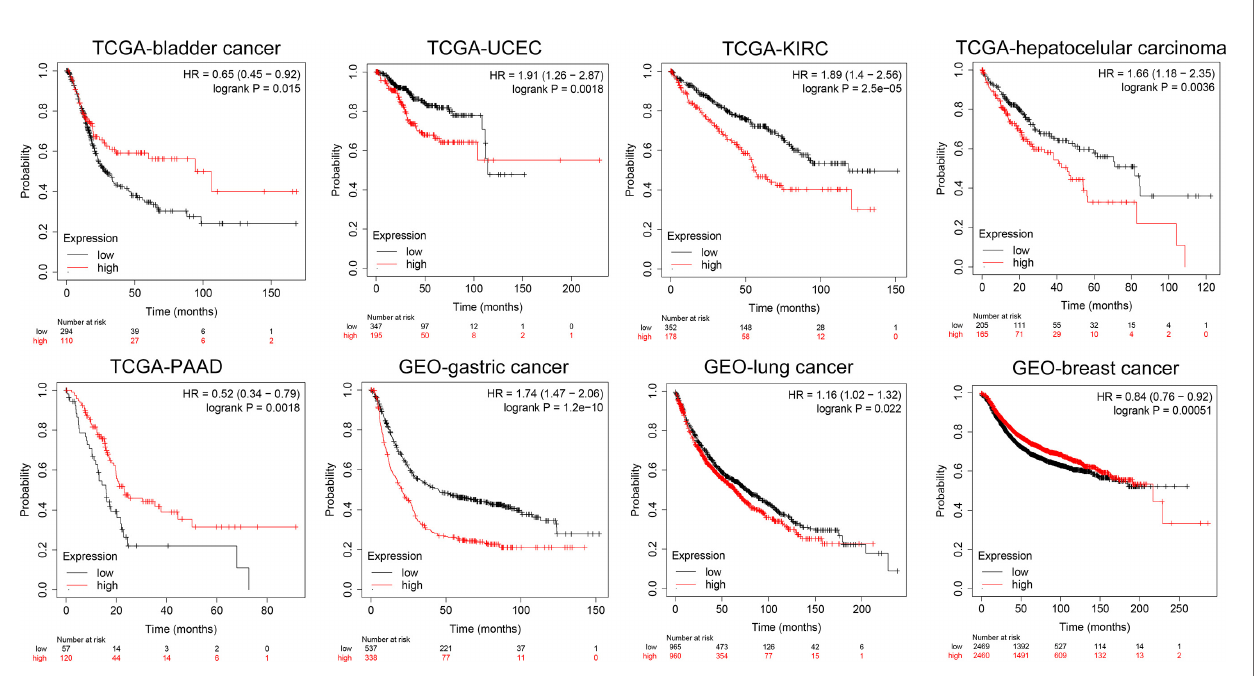
FIGURE 4 | Subgroup survival analysis indicated high expression of KCC2 is associated with poor survival for pan-cancer patients. Bladder cancer (HR = 0.65, p = 0.015, TCGA), PAAD (HR = 0.52, p = 0.0018, TCGA), breast cancer (HR = 0.84, p = 0.00051, n = 4,929, GEO), UCEC (HR = 1.91, p = 0.0018, TCGA), KIRC (HR = 1.89, p < 0.001, TCGA), LIHC (HR = 1.66, p = 0.0036, TCGA), gastric cancer (HR = 1.74, p < 0.001, n = 875, GEO), and lung cancer (HR = 1.16, p = 0.022, n = 1,925,